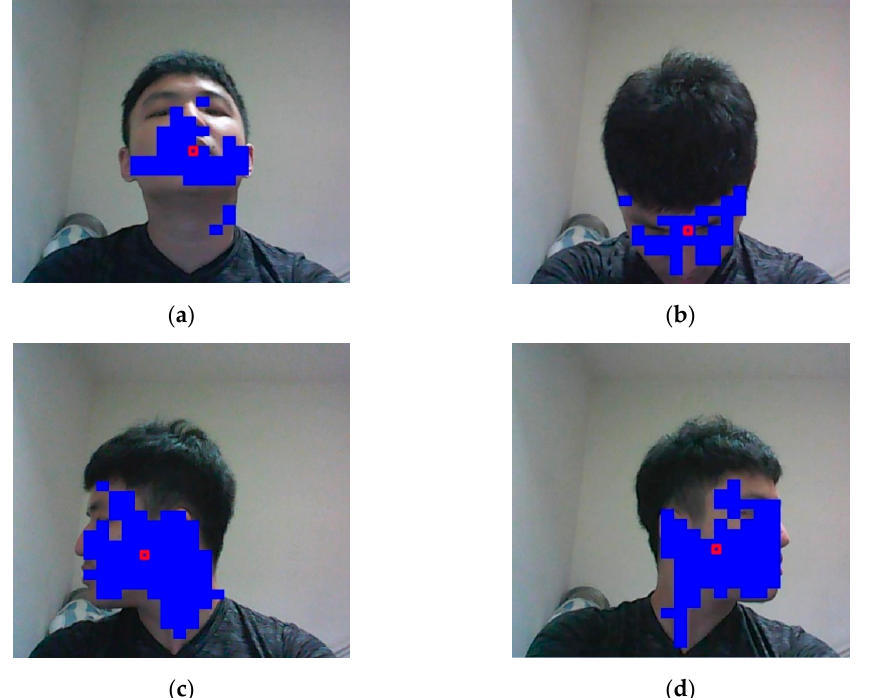
Figure 3. Test conditions of the ( a ) upward, ( b ) downward, ( c ) rightward, and ( d ) leftward movements of the head.